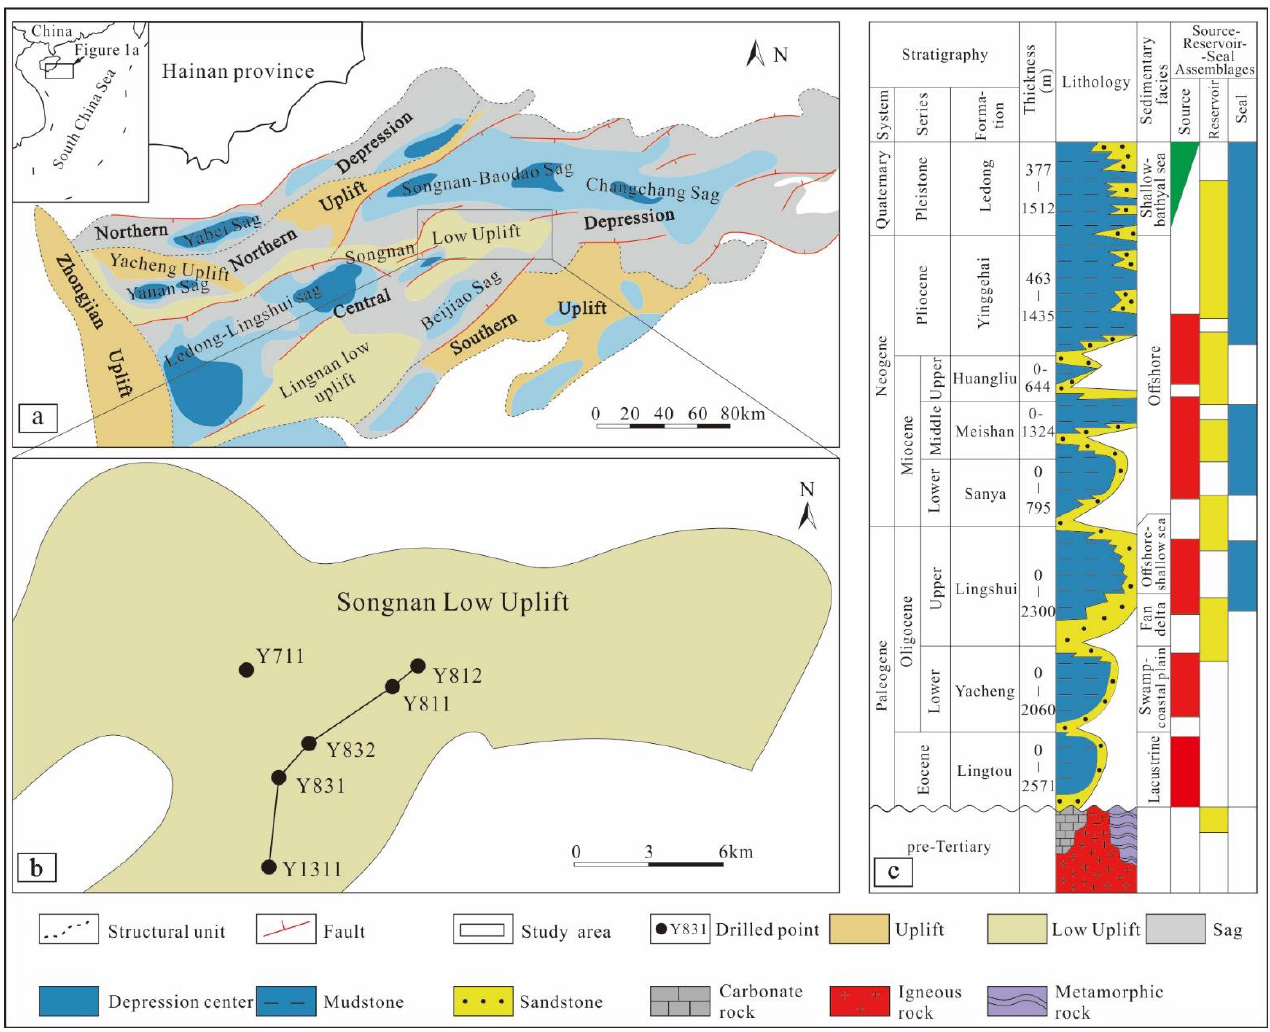
Figure 1. Tectonic framework and comprehensive stratigraphic column of the Qiongdongnan Basin. ( a ) Tectonic map of the Qiongdongnan Basin (after reference [16]); ( b ) drilling well location of intrusive rock buried-hill in the Y area; and ( c ) comprehensive stratigraphic column of the Qiongdongnan Basin.